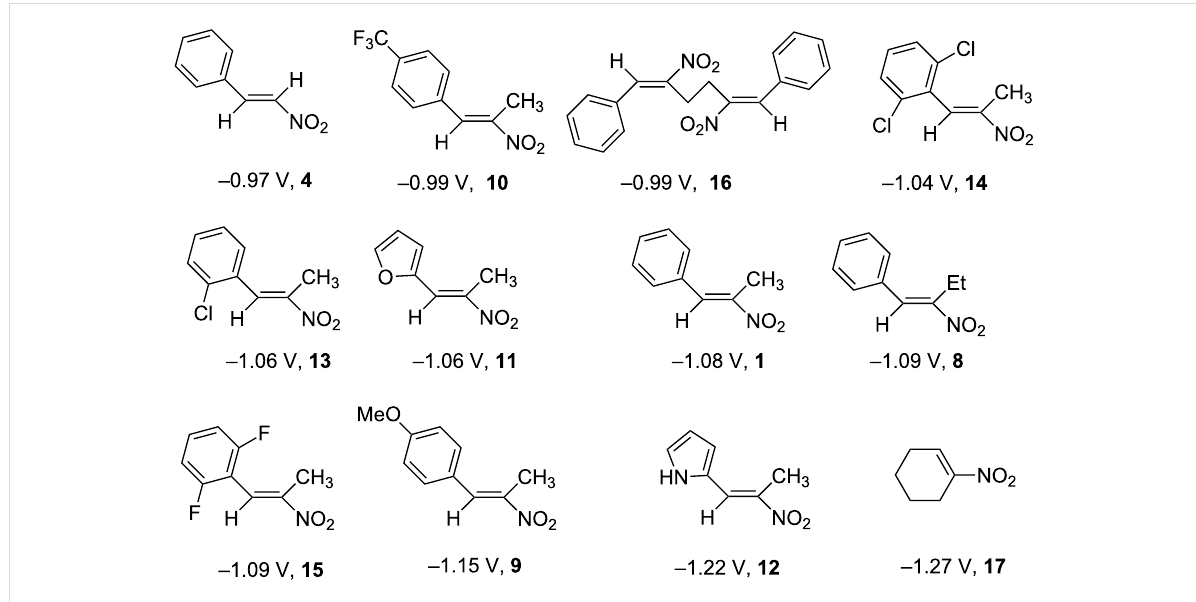
Scheme 4: Reduction potentials ( E p,c in Volt) of nitroolefins. Conditions: amalgamated gold wire, v = 0.1 V/s, 0.2 M TEA- p Tos in DMF, accuracy of E p,c = +/ − 0.02V vs SCE, measured against the Marple electrode and converted to